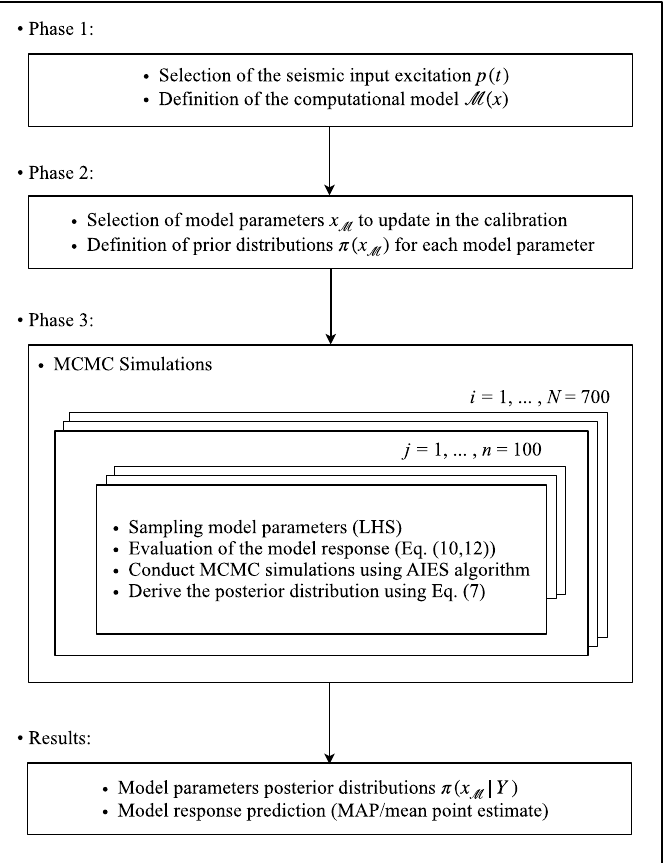
Figure 1. Flowchart of the Bayesian model calibration procedure.